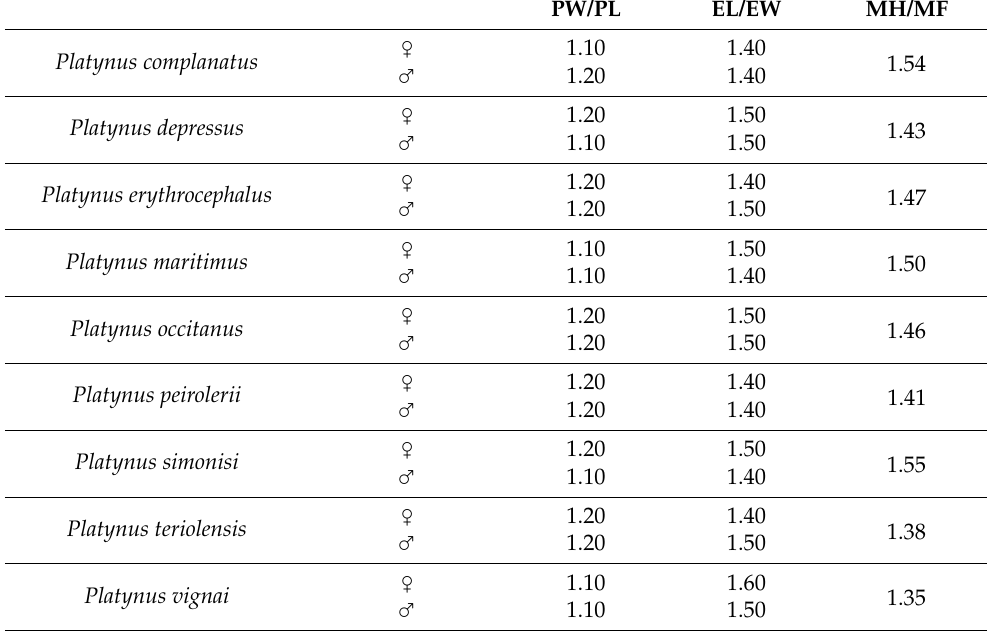
Table 4. Ratio between the linear measurements of each species of Platynus . In the table, the acronyms correspond to: PL = pronotum maximum length, measured from anterior to the basal angle; PW = pronotum maximum width; EL = elytron maximum length, from shoulder to apex; EW = elytron maximum width; MH = maximum head width across eyes; MF = minimum frons width between eyes. PW/PL EL/EW